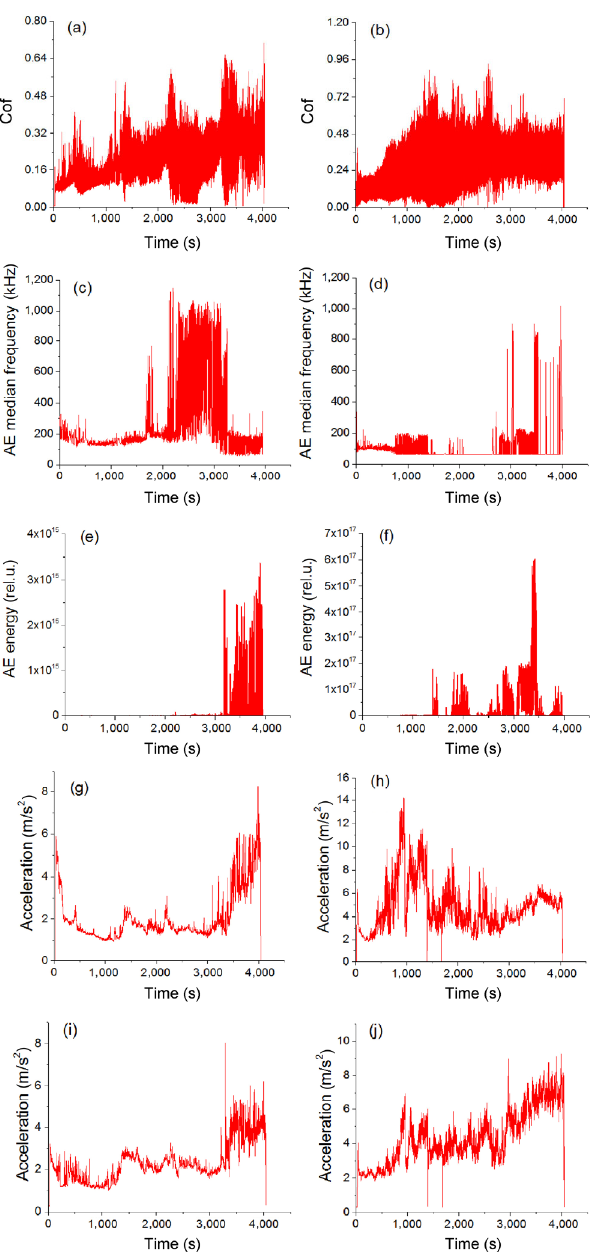
Fig. 1 Time dependencies of friction coefficient ((a), (b)), AE median frequency ((c), (d)), AE energy ((e), (f)), and vertical ((g), (h)) and horizontal ((i), (j)) vibration acceleration RMS for Y-TZP ceramics obtained in sliding at 0.5 m/s, 13 N ((a), (c), (e), (g), (i)) and 26 N ((b), (d), (f), (h), (j)) normal load.